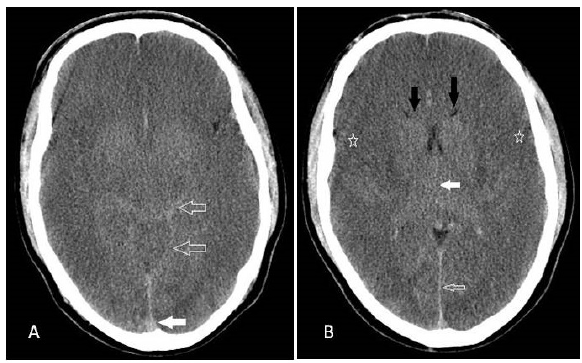
Figure 1. Non-contrast axial brain CT scan showing diffuse brain edema and loss of gray white matter differentiation. (A) Hypoattenuation of superior sagittal sinus (solid arrow) and quadrigeminal and ambient cistern (hollow arrows). (B) Hypoattenuation of inter-hemispheric fissure (hollow arrow), effacement of third ventricle (solid white arrow), both sides lateral sulcus ( ), frontal horns of lateral ventricles (solid black